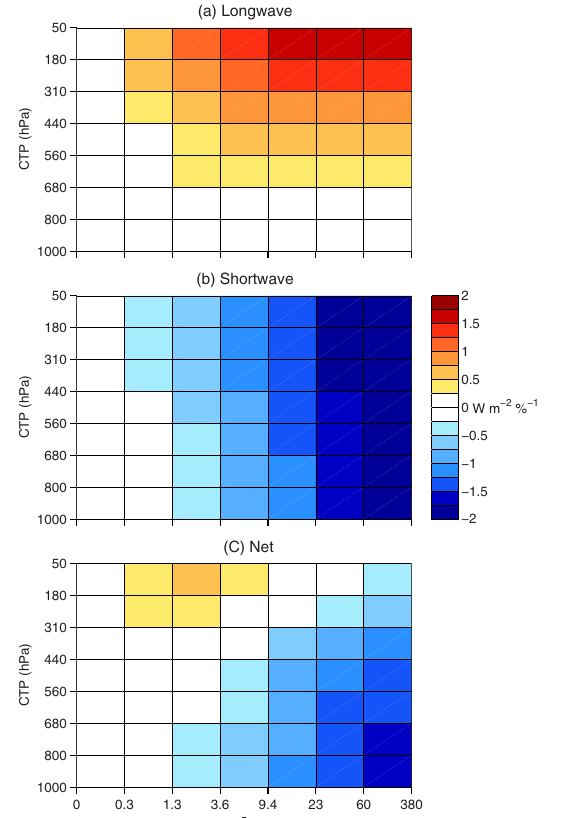
Figure 4. Global, annual, and ensemble mean (a) LW, (b) SW, and (c) net cloud radiative kernels. In each model, the kernels have been mapped to the control climate’s clear-sky surface albedo distribution before averaging in space; thus, the average kernels are weighted by the actual global distribution of clear-sky surface albedo in each model. Redrawn with modification from Zelinka et al.